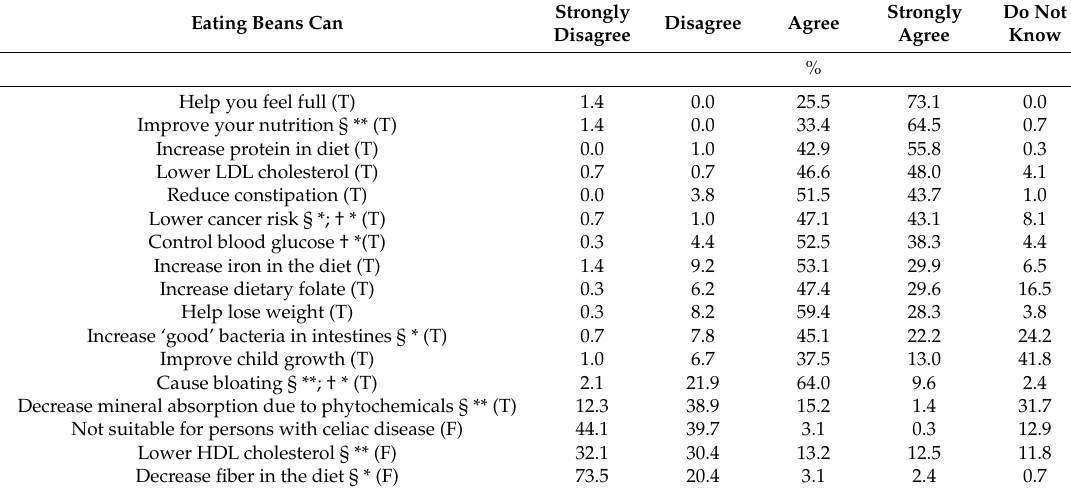
Table 2. Percentage distribution of responses to statements of the health benefits of beans among Arizona Registered Dietitians ( n = 296; T = true statement, F = false statement). Strongly Disagree Eating Beans Can Disagree